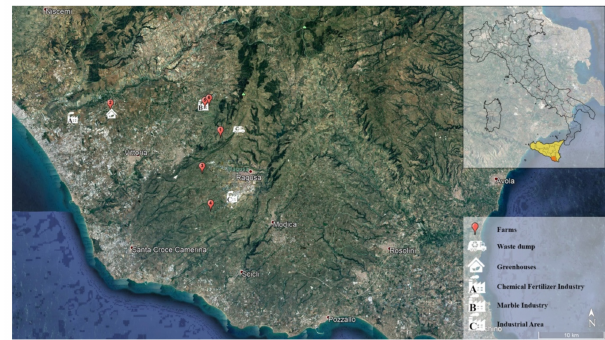
Figure 1. Map of the province of Ragusa, Italy, with geolocation of farms and anthropogenic activities.